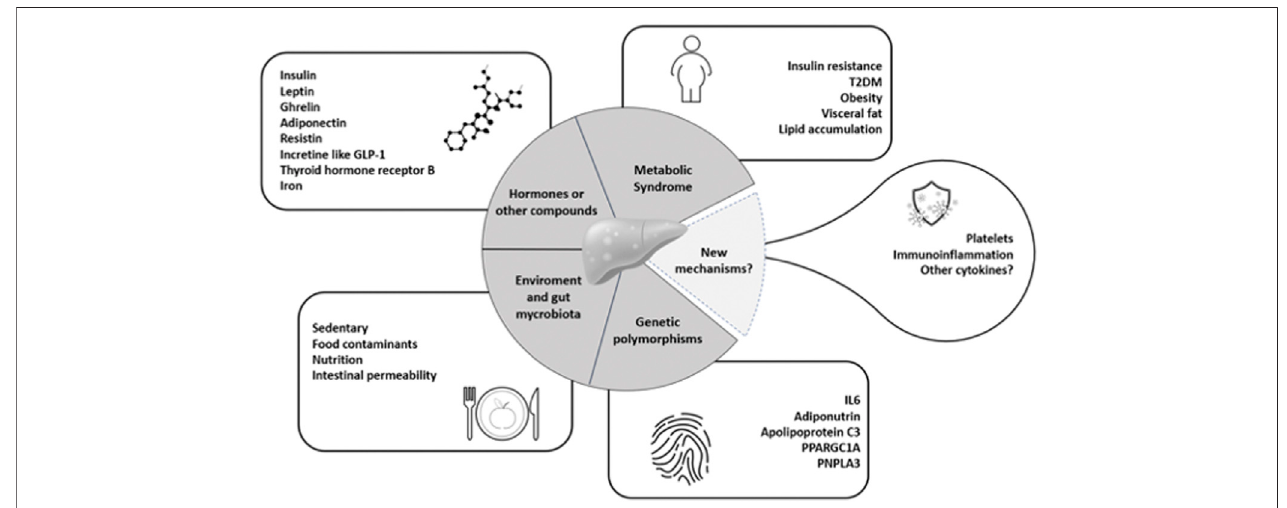
FIGURE 1 | Main determinants of